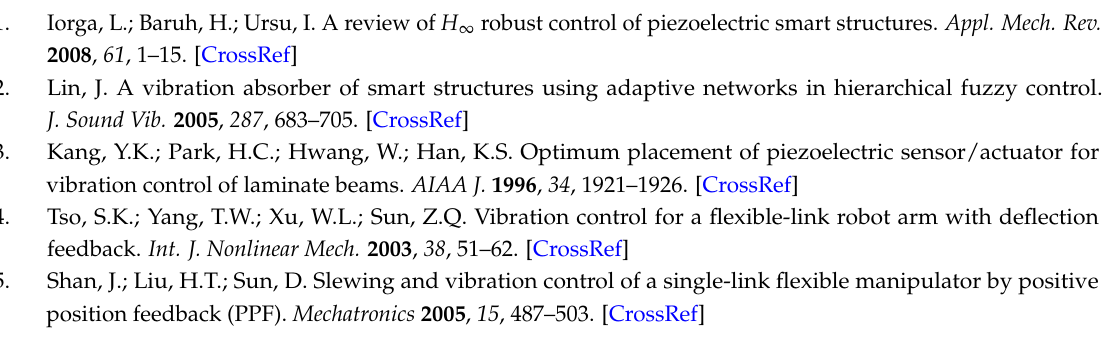
Figure 16. Fuzzy rule bank used in hybrid AFSMC/RC vibration control system.